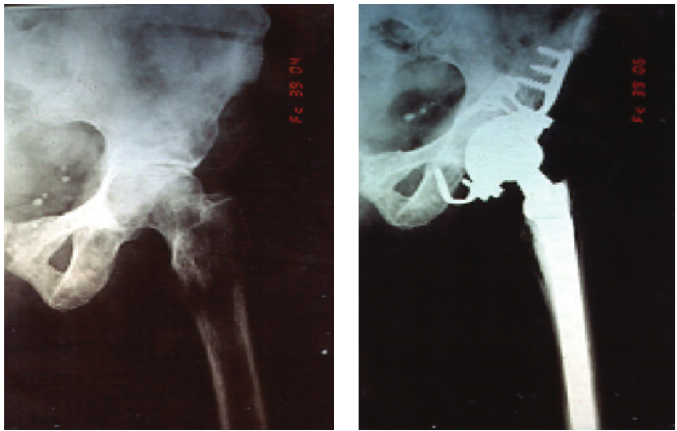
Figure 5: Pre- and postoperative radiographies for Harrington Class 2 bone defect.